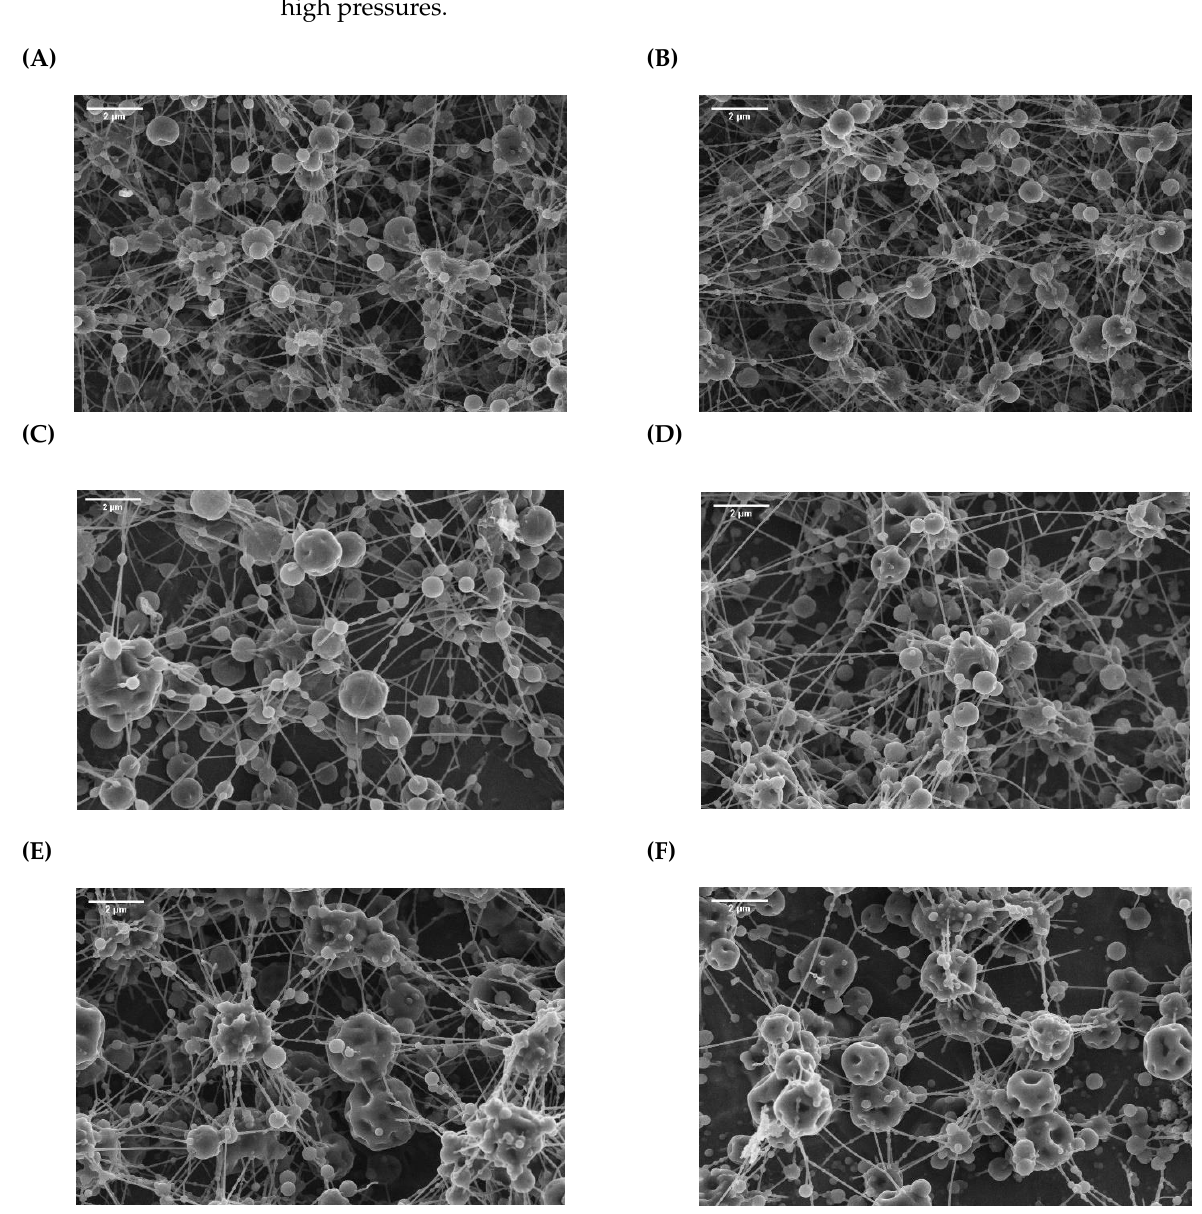
Figure 2. SEM images (A – F) of the electrosprayed capsules (monoaxial and coaxial) loaded with fish oil: GS-mo (monoaxial) (A) ; MD-mo (monoaxial) (B) ; GS-co (coaxial) (C) ; MD-co (coaxial) (D) ; GS-HPH-co (coaxial) (E) ; MD-HPH-co (coaxial) (F) . Scale bar: 2 µm.